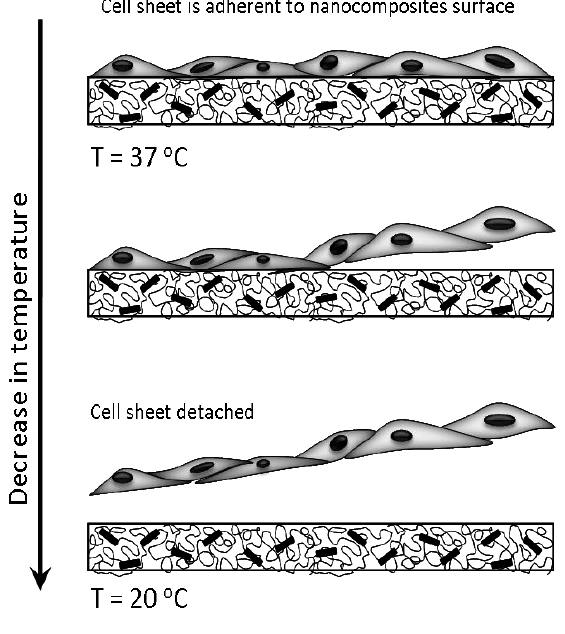
Figure 2. Cell sheets can be isolated by culturing cells on temperature responsive polymer nanocomposite materials. After reaching confluency, a cell sheet is detached by decreasing the temperature. When the temperature drops below the lower critical solution temperature, the change in polymer conformation causes cells to detach